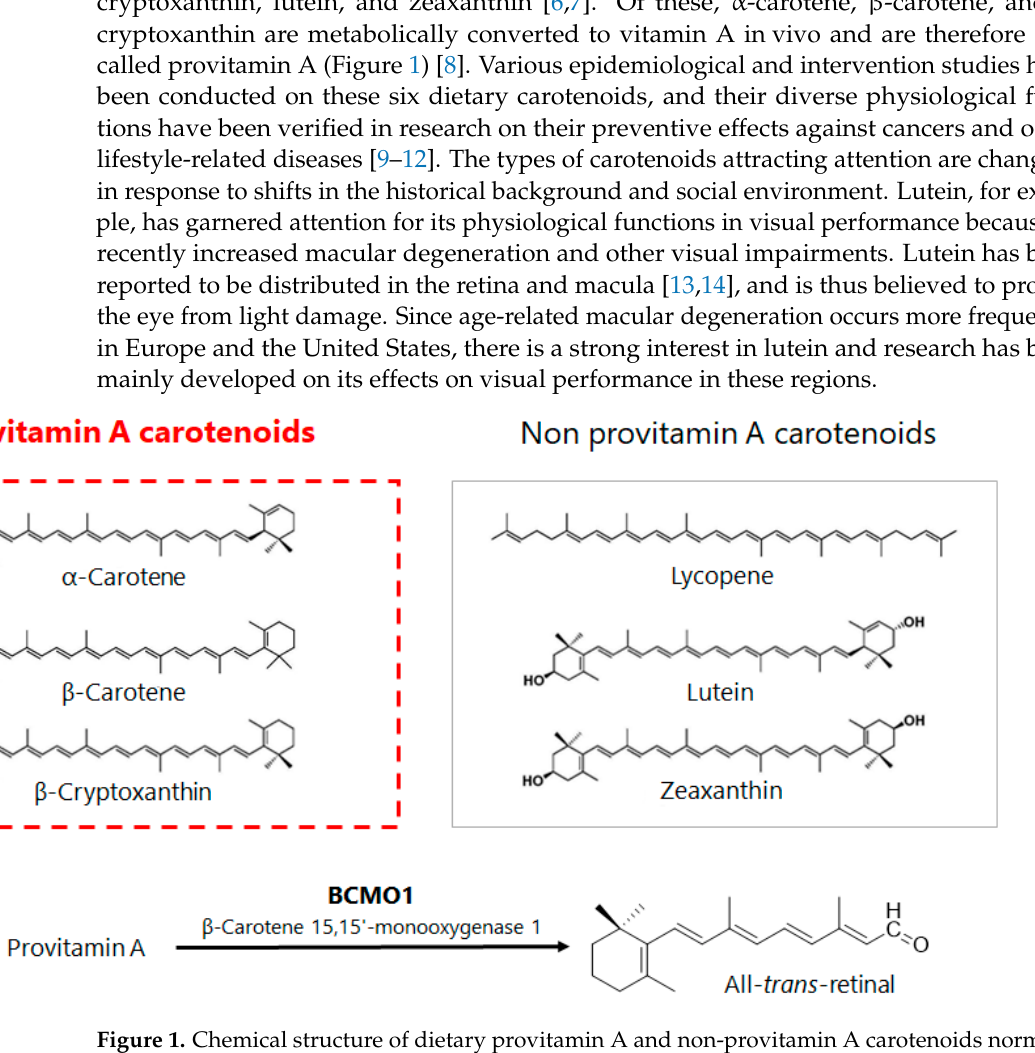
Figure 1. Chemical structure of dietary provitamin A and non-provitamin A carotenoids normally present in human blood, and metabolic conversion of provitamin A to all-trans-retinal by β -carotene 15,15 ′ -monooxygenase 1 (BCMO-1): Carotenoids are defined as yellow to red natural colorants bio-synthesized by plants and algae, characterized to express high anti-oxidative activities, and found to have physiologically defensive functions on visual performance, life-style related diseases and cancers. Six kinds of dietary carotenoids are normally present in human blood.